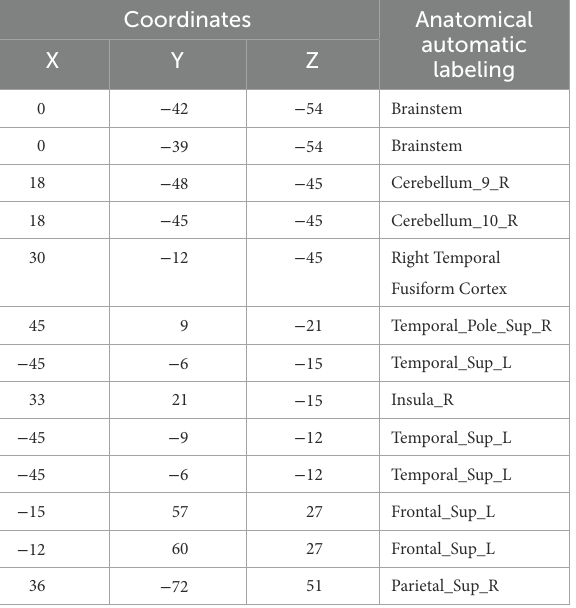
TABLE 2 Gray matter brain areas with significant differences between the PD and control groups based on anatomical automatic labeling.